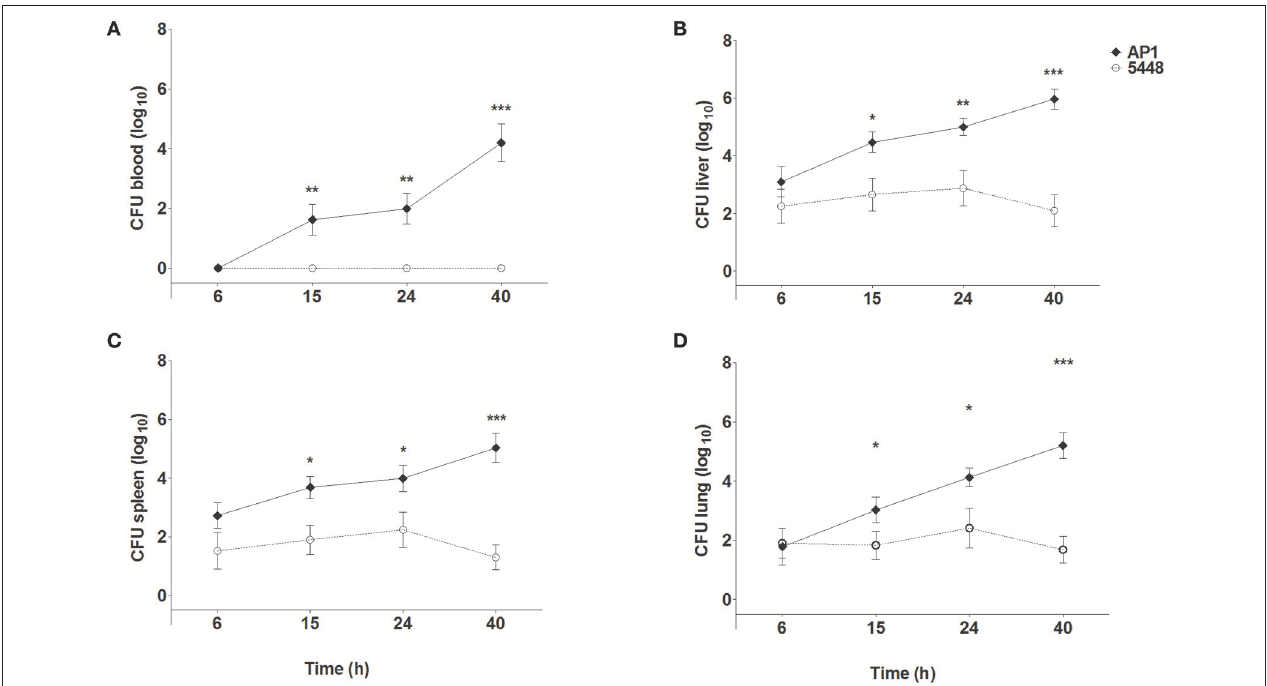
FIGURE 1 | Bacterial loads in blood (A) , liver (B) , spleen (C) , and lung (D) of mice infected with S. pyogenes strains AP1 or 5448. Female C57BL/6J mice were infected subcutaneously on the back with 5 × 10 7 CFU S. pyogenes. After the indicated time points, mice were sacrificed, blood was drawn by cardiac puncture, and livers, spleens and lungs were dissected and homogenized in PBS. Blood samples and organ homogenates were plated onto blood agar plates in 10-fold serial dilutions. Bacterial loads were determined by counting colonies after 18h of incubation at 37 ◦ C. For simplicity sake, the value of 10 0 (corresponding to one hypothetical colony) was inserted for all samples with sterile culture. The graphs show mean ± SD of 7–10 mice per group, combined from three independent complete time course experiments. * P ≤ 0.05, ** P ≤ 0.01, *** P ≤ 0.001. Unpaired T